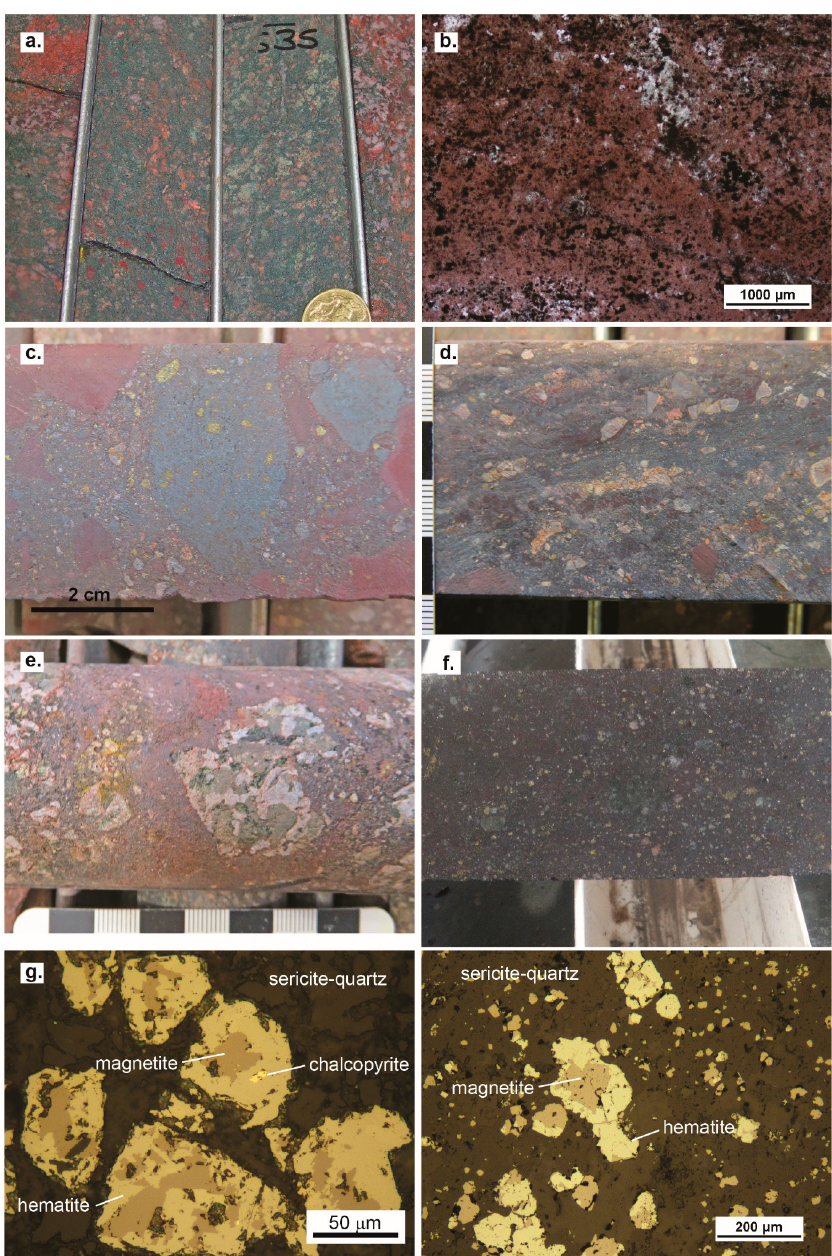
Figure 9. Examples of hematite-sericite-chlorite alteration styles and hematite breccia from the Olympic Cu-Au Province. ( a ) Chlorite-sericite-altered granite, drill hole MGD 34, ~535 m. Granite is 1850 Ma Donington Suite. ( b ) Fine-grained sericite-chlorite-hematite alteration. Emmie Blu ff prospect, sample 1,833,355, drill hole SAE 7966.5 m. ( c ) Hematite breccia from Olympic Dam. Underground drill hole RU39. Note multi-phase brecciation, with clasts of hematite breccia within the hematite breccia matrix. ( d ) Hematite breccia from Prominent Hill discovery hole, Uran 1. ( e ) Clast of chlorite-sericite-altered granite (1850 Ma, Donington Suite) within hematite breccia, Carrapateena deposit. Drill hole CAR02, 585 m. ( f ) Fine-grained hematite breccia with minor sulfides, Vulcan prospect. Drill hole RCDD11VUD007, 1138 m [130]. Drill core ~5 cm wide. ( g ) Thin section photomicrograph showing relict magnetite cores within hematite. Note pyrite in one of the hematite pseudomorphs. Sample 1838226, drill hole RCDD11VUD007, 1202.3 m. h. A second example of relict magnetite cores within hematite. Emmie Blu ff prospect, sample 1,833,355, drill hole SAE 7966.5